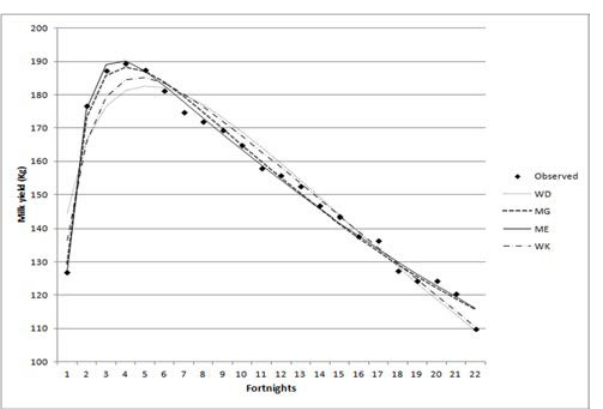
Figure-1: Average fortnightly milk yields and p redicted value for different lactation curve models.